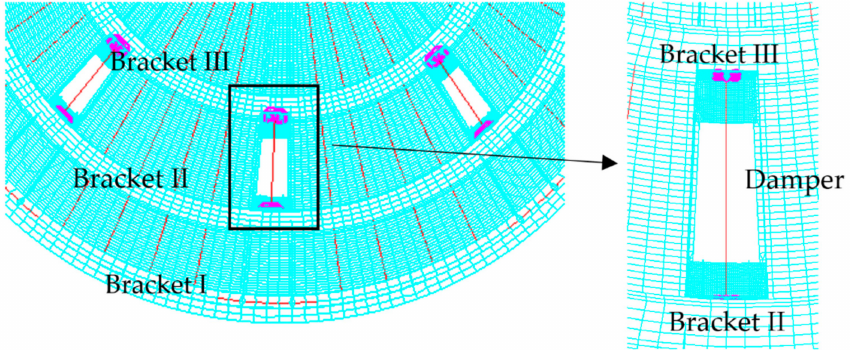
Figure 5. Finite element modeling of the damping system on the Payload Adaptor Fitting (PAF).